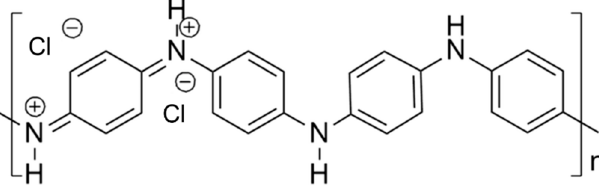
Figure 1. Structure of PANI in form of emeraldine salt (for the tetrameric unit n = 1). The percentage of PANI on LS corresponded to ca. 6.5 wt.%.